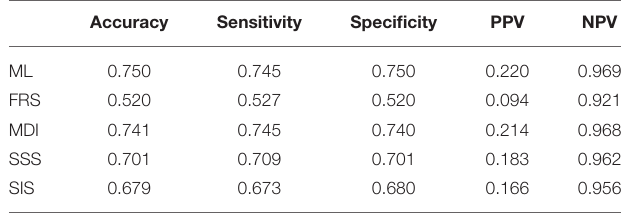
TABLE 2 | Accuracy, sensitivity, specificity, positive predictive value, and negative predictive value of our ML method and existing methods for prediction of all-cause mortality.